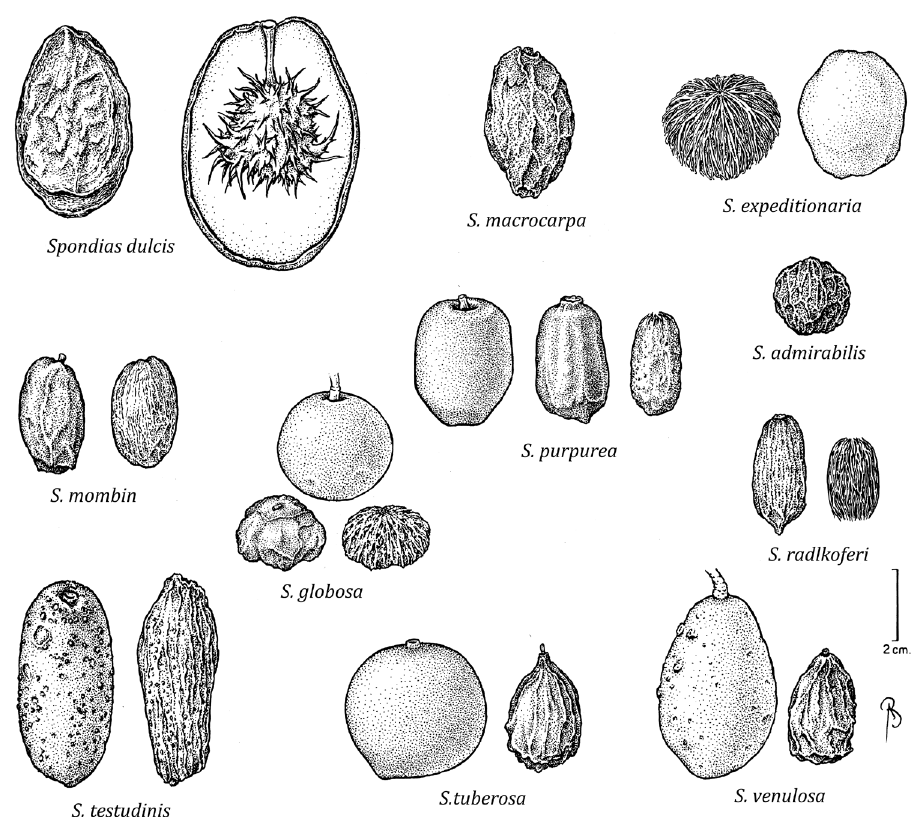
Figure 16. Fruits of Neotropical Spondias. Spondias dulcis (dry fruit: Berlin 870 , NY; and longisection: unvouchered photo), S. macrocarpa (dry fruit: Thomas et al. 6823 , NY), S. expeditionaria (endocarp and fresh fruit: Lorenzi s.n. , NY), S. mombin (dry fruit: Mostacedo 2941 , NY; endocarp: Moraes 1046 , NY), S. globosa (fresh fruit [top], dry fruit, and endocarp: Daly et al. 8472 , NY), S. purpurea (fresh fruit: un- vouchered photo; dry fruit: Moreno 2827 , NY; endocarp: Magallanes 3887 ), S. admirabilis (dry fruit: Farney et al. 4046 , NY), S. radlkoferi (dry fruit: Nee 6729 , NY; endocarp: Moran 6291 , NY), S. testudinis (fresh and dry fruit; Daly et al. 7559 , NY), S. tuberosa (fresh fruit: from Morton, 1987; dry fruit: Mattos Silva 2299 , NY), and S. venulosa (fresh fruit: from photo in Lorenzi, 1998; dry fruit: Araújo 7828 ,